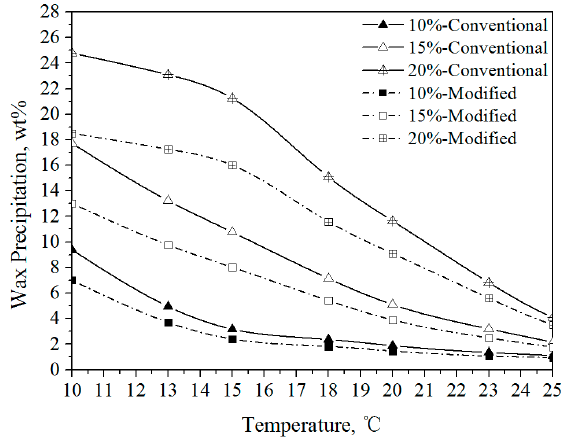
Figure 5. The amount of wax precipitated at different temperatures using the conventional and modified methods.